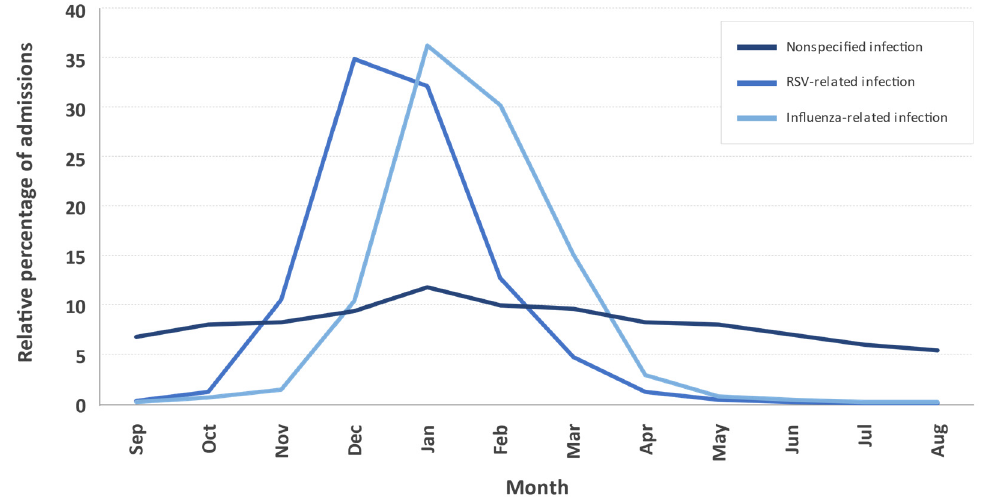
Figure 3. Monthly distribution of the relative mean percentage of admissions for the indicated diagnostic groups throughout the year in Spain between 2012 and 2020.